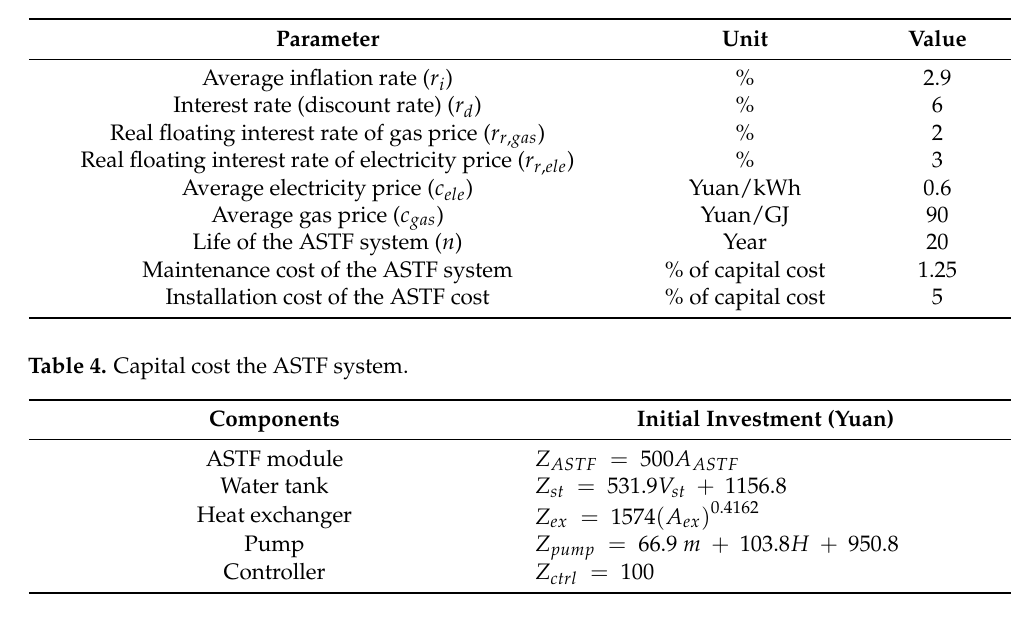
Table 3. Parameters used in the economic analysis [30].